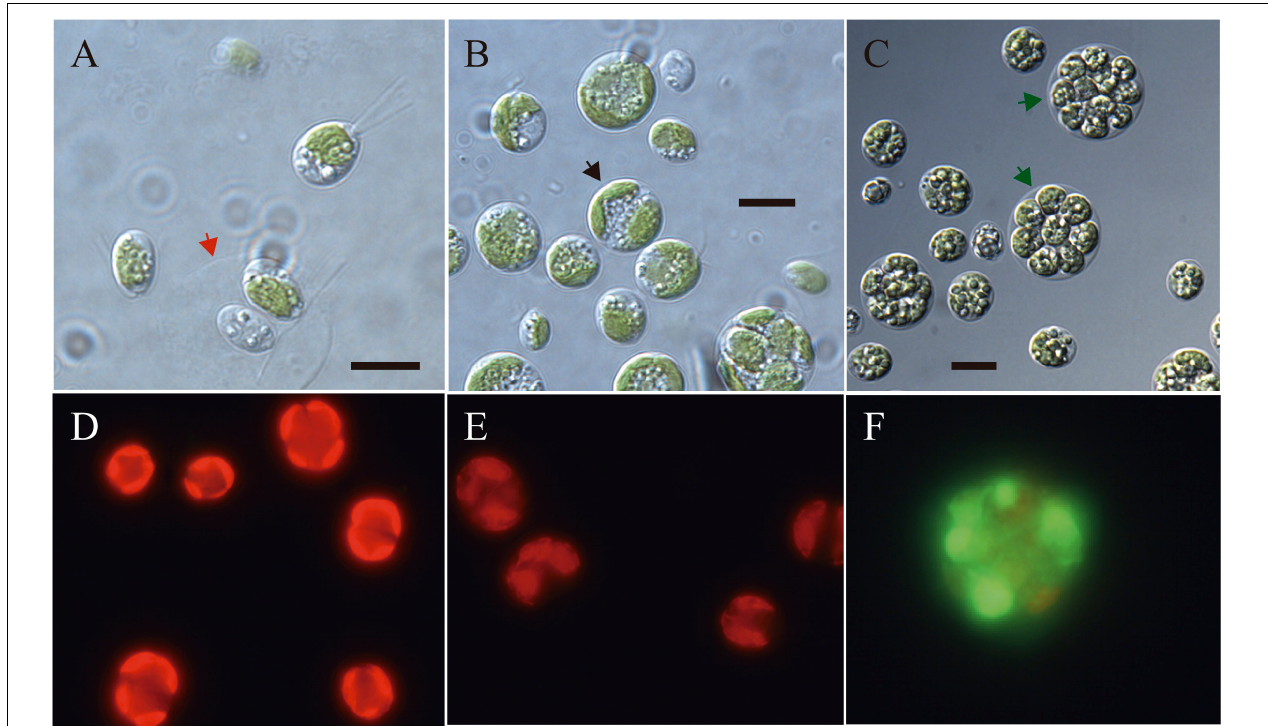
FIGURE 2 | (A–C) Light microscopy images of morphology of Chlorominima collina CCAP 6/1 (A) Zoospores with two flagella of equal length. The red arrow indicates the maternal cell wall, from which the zoospores emerged. (B) Vegetative cells in the process of cell division. Black arrow points to a cell in division. (C) Mature cells with higher amounts of starch grains and lipid droplets. Green arrows indicate zoospores within mother cell wall. (D–F) Fluorescence images of Chlorominima collina using CellROX Green dye for detection of ROS in vivo on the third day of exposure at the control temperature of 2 ◦ C (D) and at the treatment temperatures of 10 ◦ C (E) and 20 ◦ C (F) . In panels (D,E) red stained chloroplasts of dividing cells are observed and in panel (F) the dividing cell ( ≥ 4 zoospores) is almost completely stained green. Scale bars: 10 µ